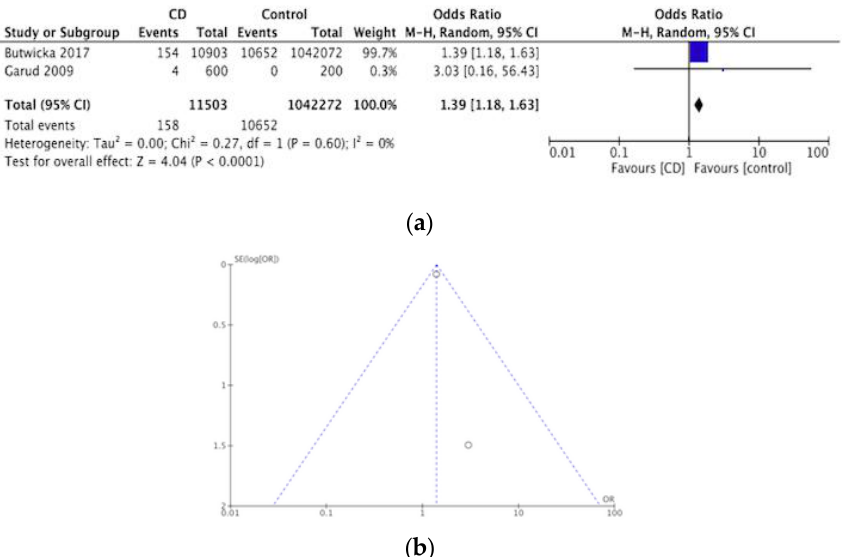
Figure 3. ( a ) Forest plot of pooled prevalence of ADHD in CD. ( b ) Funnel plot investigating distribution in ADHD studies. in ADHD